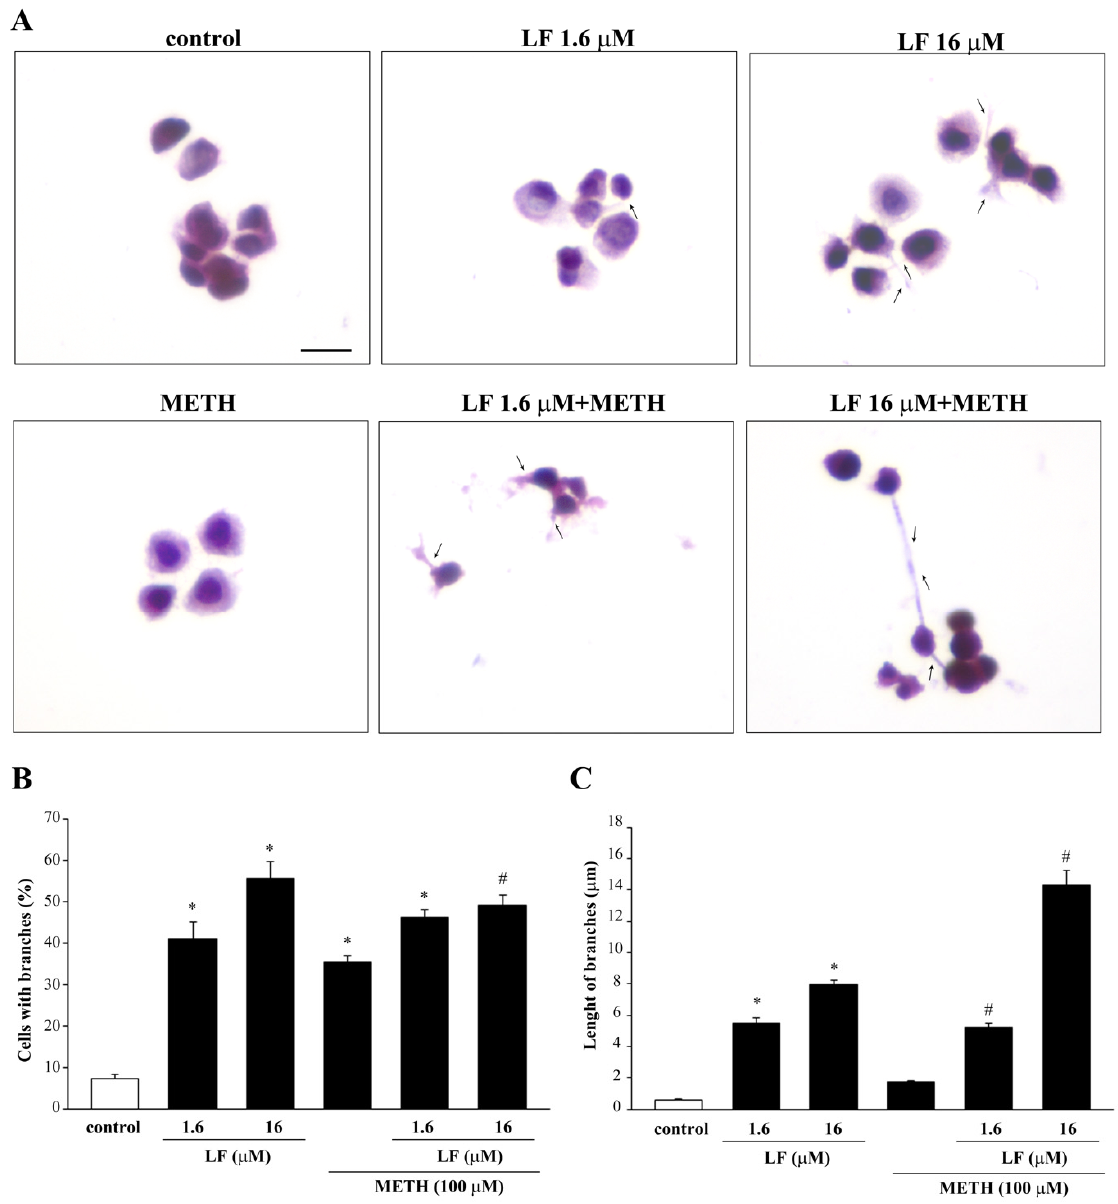
Figure 6. METH enhances the growth of cell elongations induced by LF. ( A ) Representative pictures of H&E-stained branching out of PC12 cells after combined LF and METH treatment. Arrows indicate cell elongations. The histograms report ( B ) the mean number of cells with branches and ( C ) the mean length of branches observed in each experimental group. * p < 0.05 compared with control; # p < 0.05 compared with METH. Scale bar = 12 µ